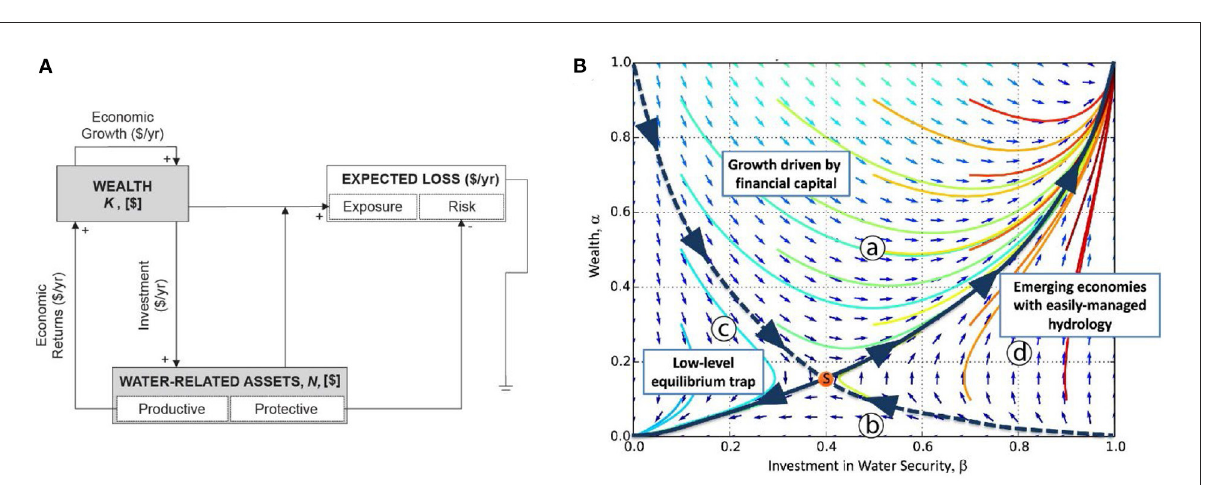
FIGURE4 (A) Description of the water security model of Dadson et al. (2017) and (B) a resultant phase space (reproduced with permission).